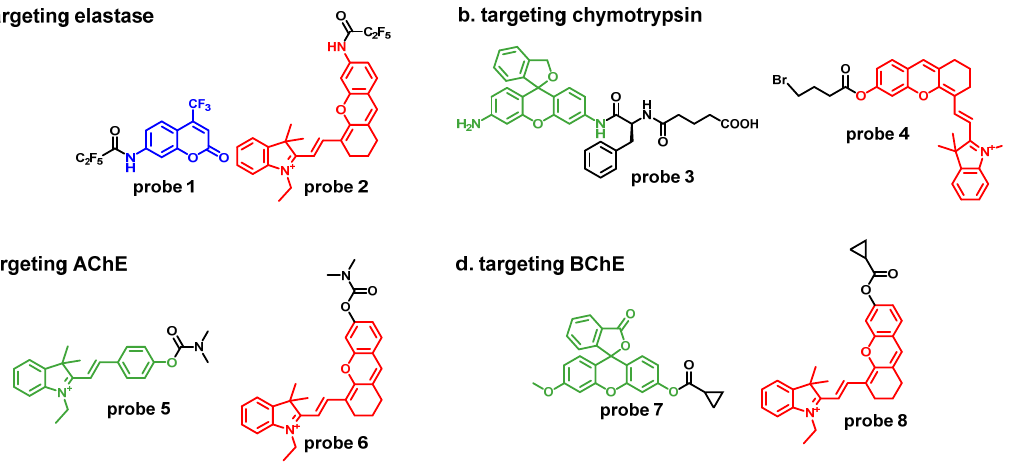
Figure 2. ( a ) The structures of probes 1 and 2 ; ( b ) The structures of probes 3 and 4; ( c ) the structures of probes 5 and 6; ( d ) The structures of probes 7 and 8